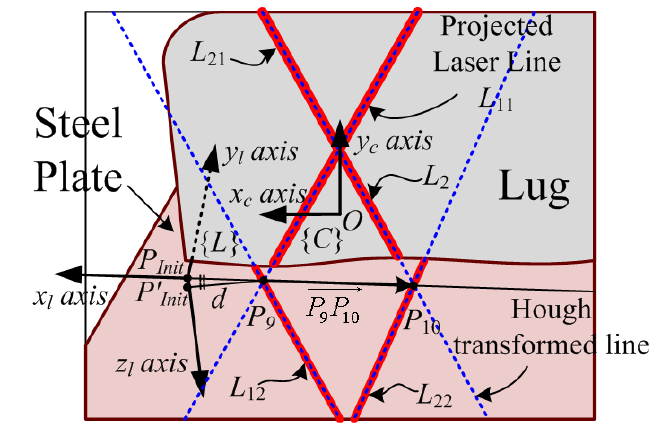
Figure 11. Side view alignment with two laser lines, L diodes, D and D , respectively. 1 2